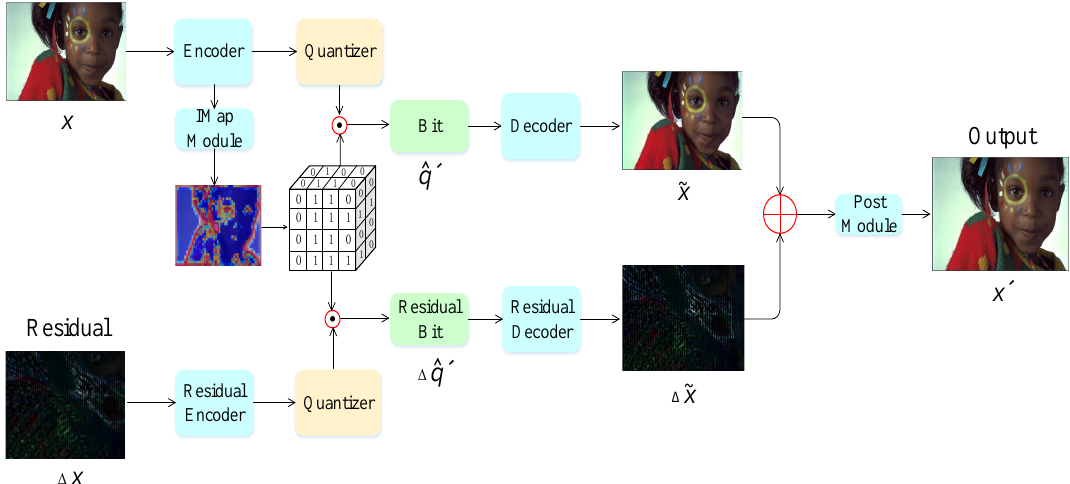
Figure 2. Proposed image compression framework. Note that, for better visualization, the salient region of the residual image was